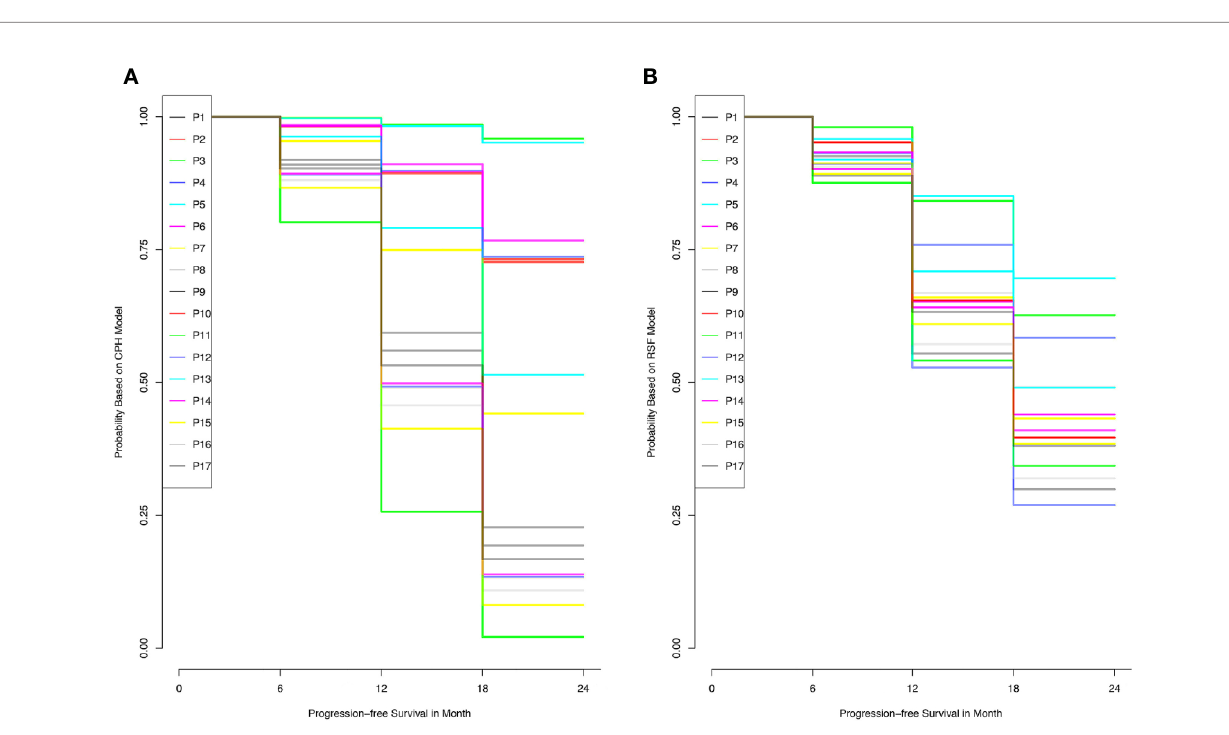
FIGURE 3 | The probability of progress-free survival for each individual in the training data set, according to the results of Cox proportional hazards model (A) and random survival forest model (B)